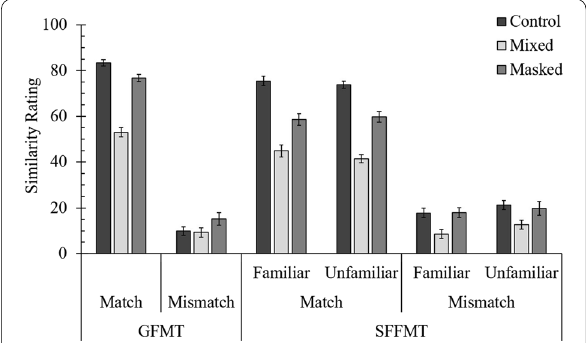
Fig. 4 Similarity ratings from the DNN, plotted separately for the match and mismatch trials of the GFMT and the SFFMT. Error bars show